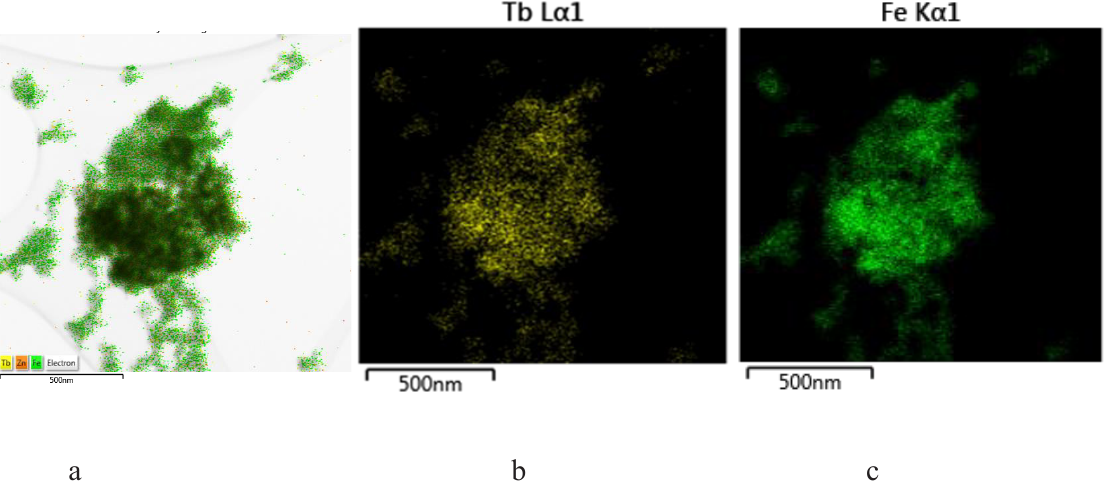
Figure 4: Elemental mapping of the sample ZNF-Tb5 (a). The equal distribution of Tb(III) on the surface is shown (b) and for comparison, the distribution of Fe(III) (c).